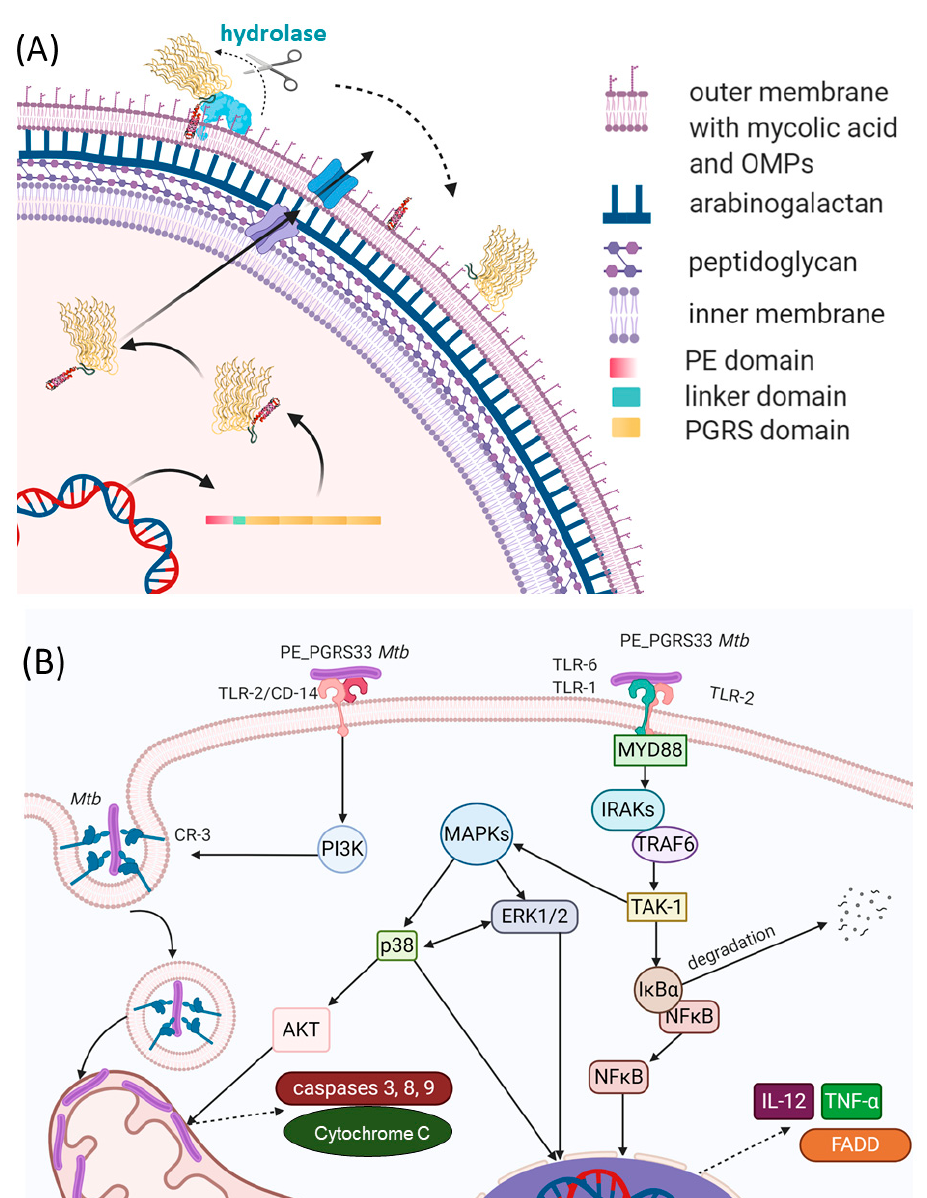
Figure 7. Schematic representations of ( A ) the PE_PGRS33 path to the mycobacterial membrane and ( B ) immune responses to PE_PGRS33 by the host.